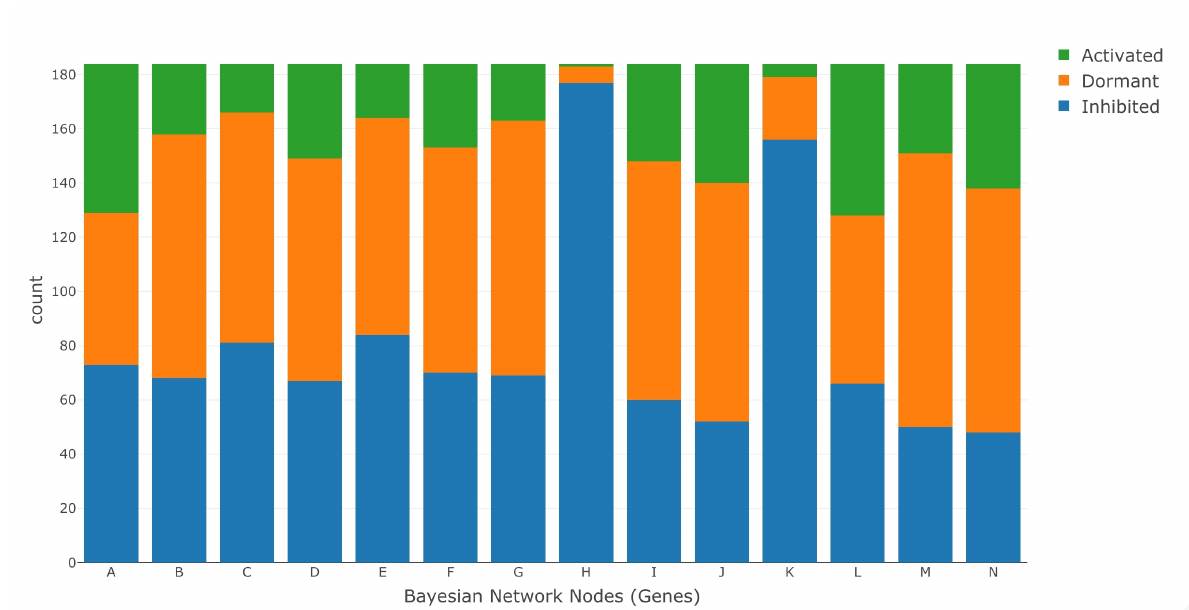
Figure 7. Discretized RNA-Seq data under saline stress